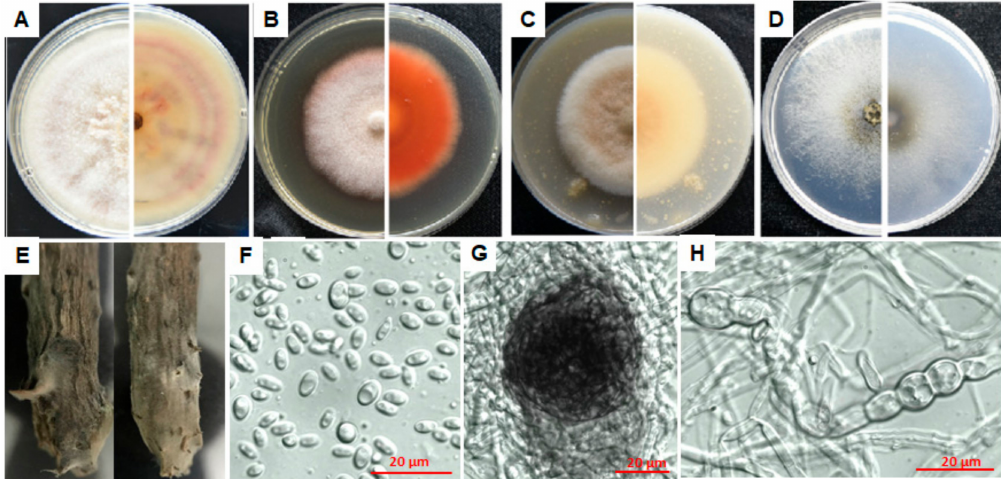
Figure 4. Morphological characteristics of Epicoccum sorghinum isolate E1. ( A – D ) The front and back of the colony morphology on PDA, MEA, OA and WA plates; ( E ), hyphae on infected twigs; ( F ), conidia were taken from sterile bayberry twigs on WA plates after 7 days of culture; ( G ), pycnidium; ( H ), chlamydospore. Photos were taken by a Nikon D750 after 7 days of culture. Fungal mycelia and spores were observed and photographed with a Zeiss Axio observer Z1 Microscope (Carl Zeiss Microscopy,